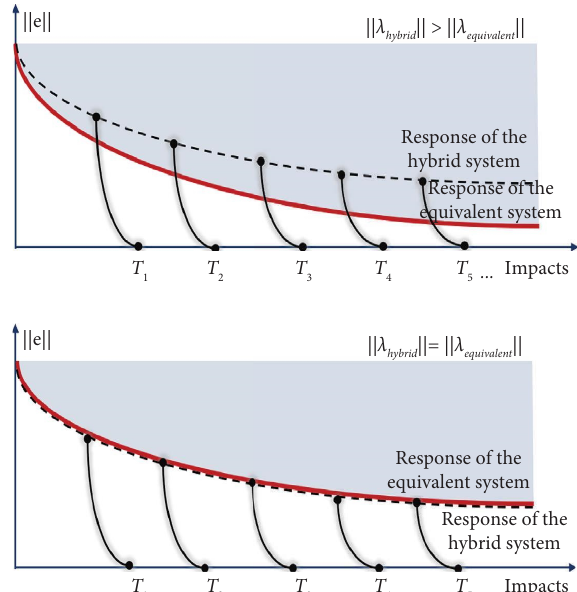
Figure 7: Evolution of the behavior of the equivalent follower robot (continuous system) and the humanoid robot (hybrid